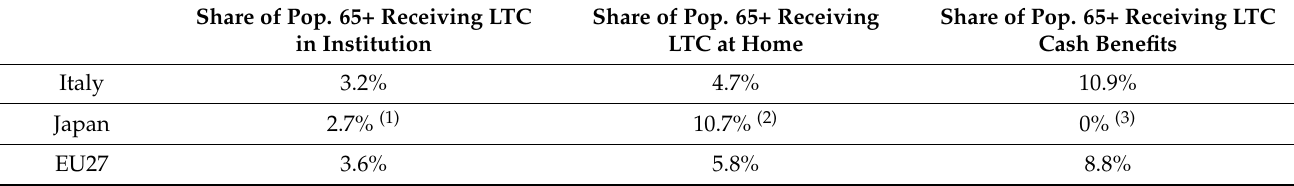
Table 3. Access to LTC in